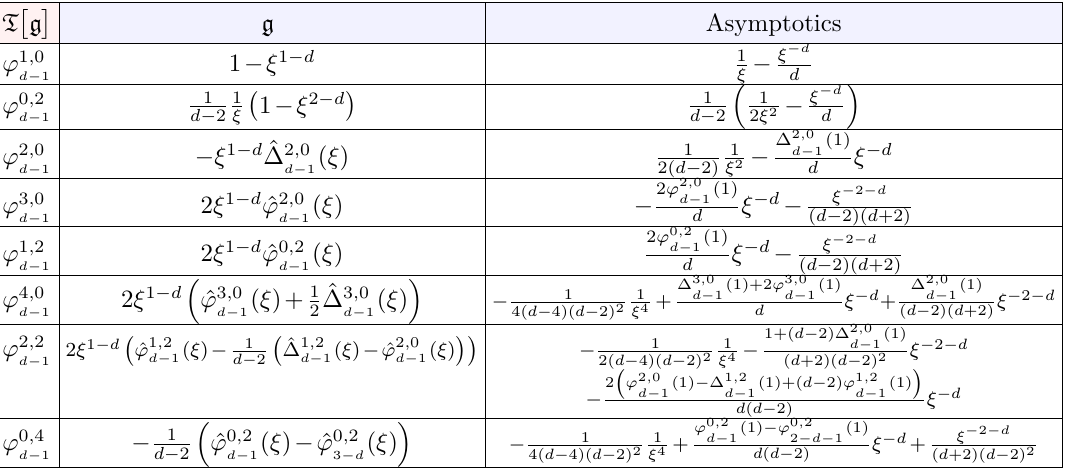
up to the fourth d − 1